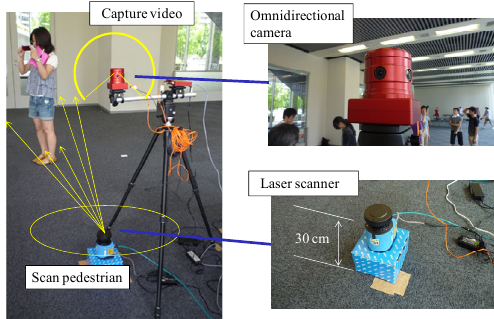
Figure 3. Position data acquisition and pedestrian tracking with an omnidirectional camera and laser scanner